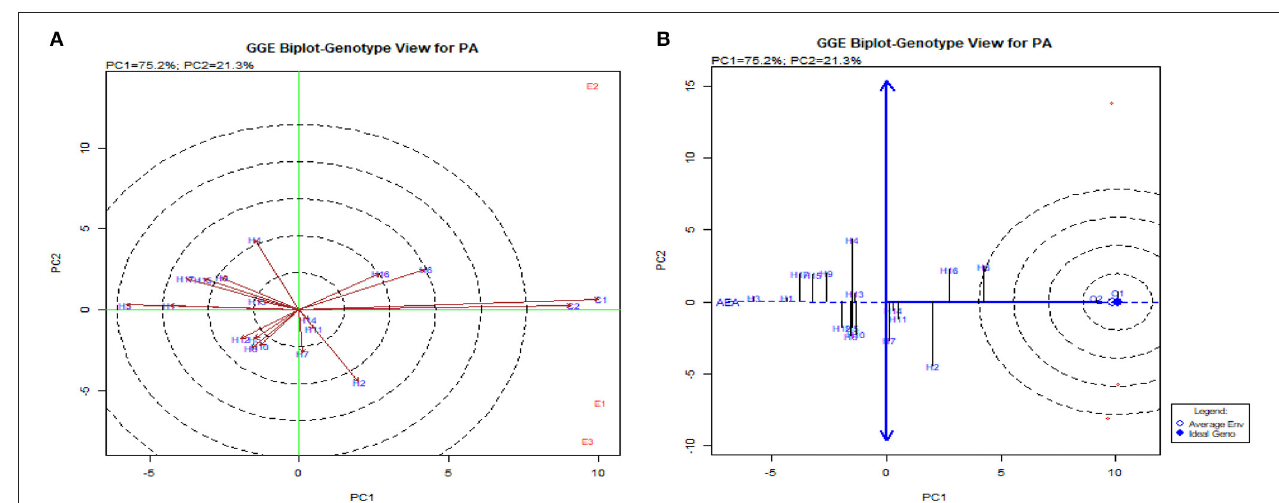
Frontiers in Plant Science |